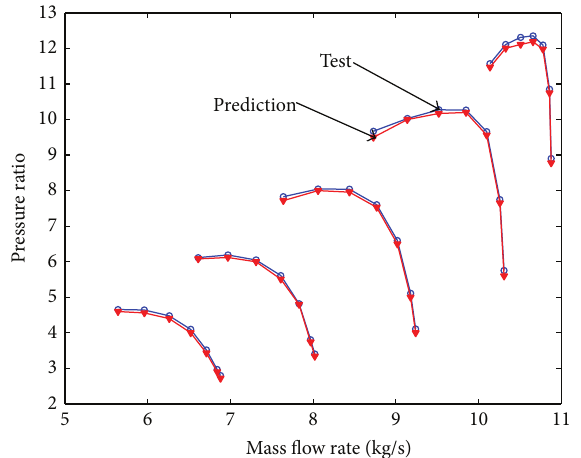
Figure 5: Pressure ratio characteristic curve for clean compressor.